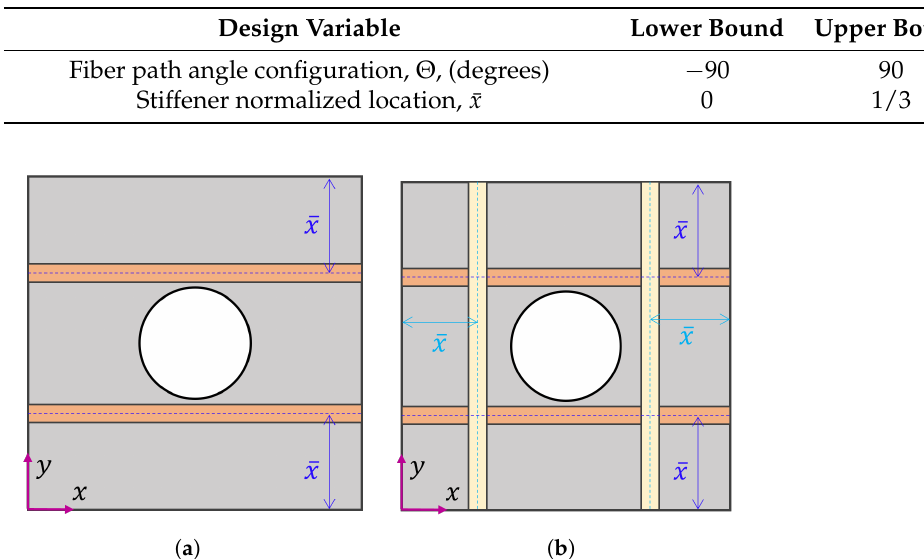
Table 3. Summary of Design Variables.